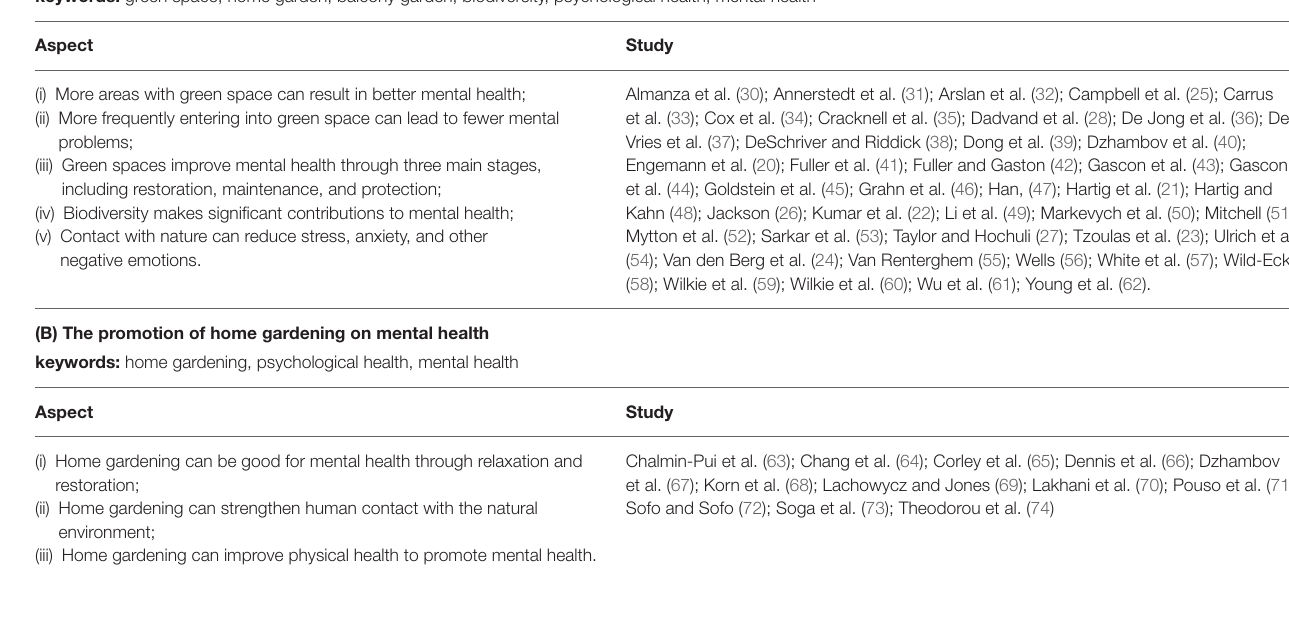
TABLE 1 | The table shows some literature discussing aspects of (A) the positive influence of a home garden on mental health; (B) the promoting effects of home gardening (a kind of physical activity) on mental health. Study